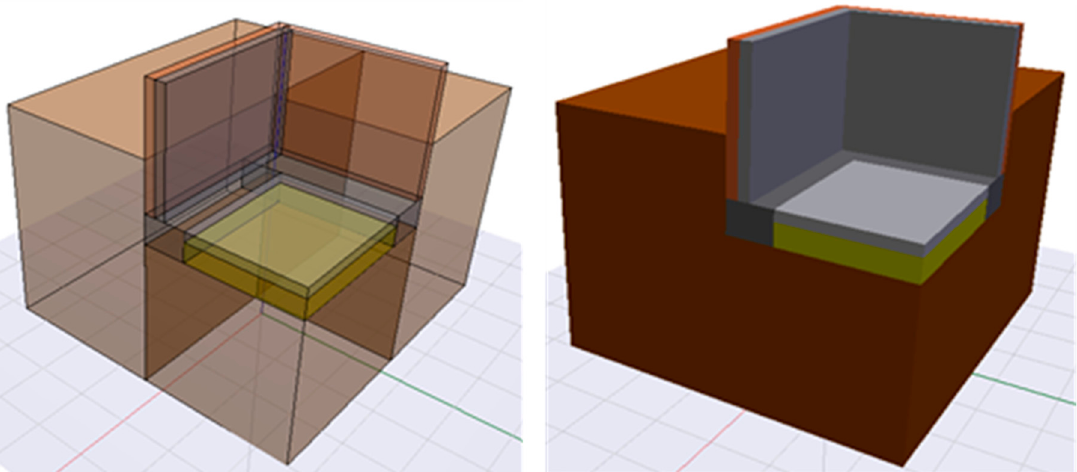
Figure 4. Geometry of the model adopted in the calculations—an example for variants W_2, W_2a, W_ 3, W_3b.